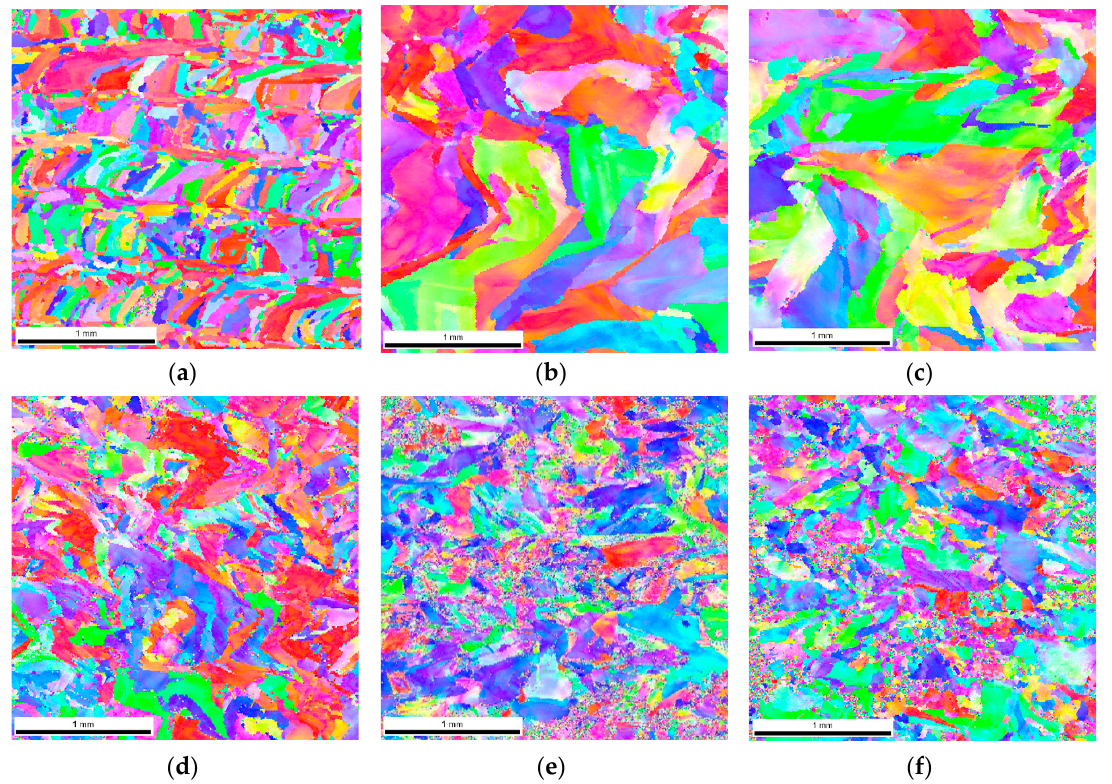
Figure 4. The microstructure illustrated with the reverse map of polar figures obtained with the electron backscattered di ff raction (EBSD) method for additively manufactured 316L subjected to dynamic plastic deformation at various rates: ( a ) not deformed; ( b ) ε = 970 s − 1 ; ( c ) ε = 1180 s − 1 ; ( d ) ε = 1700 s − 1 ; ( e ) ε = 2830 s − 1 ; ( f ) ε = 4100 s − 1